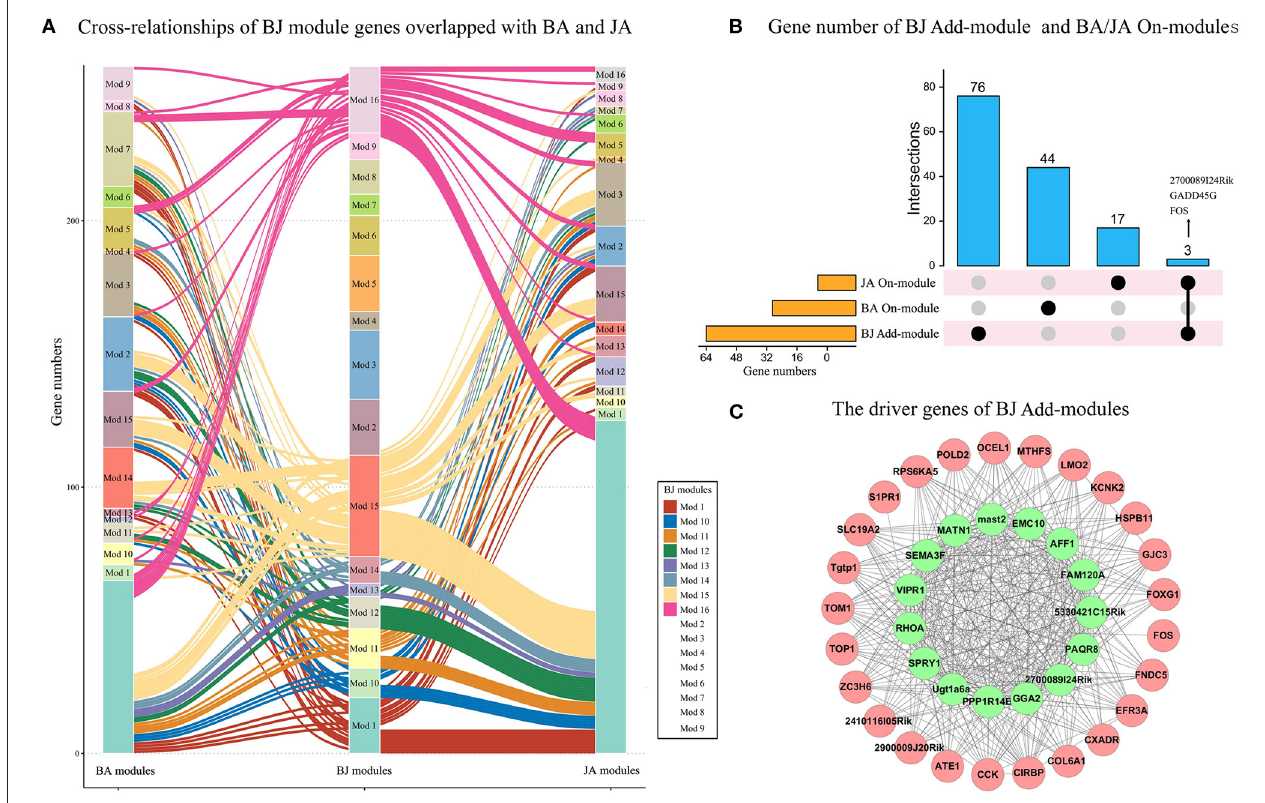
FIGURE 4 | The driver genes of BJ Add-modules. (A) The BJ module genes’ cross-relationship compared with BA and JA. (B) The BJ Add-module genes’ overlap with BA and JA On-modules. (C) The driver genes (green nodes) of BJ Add-modules.